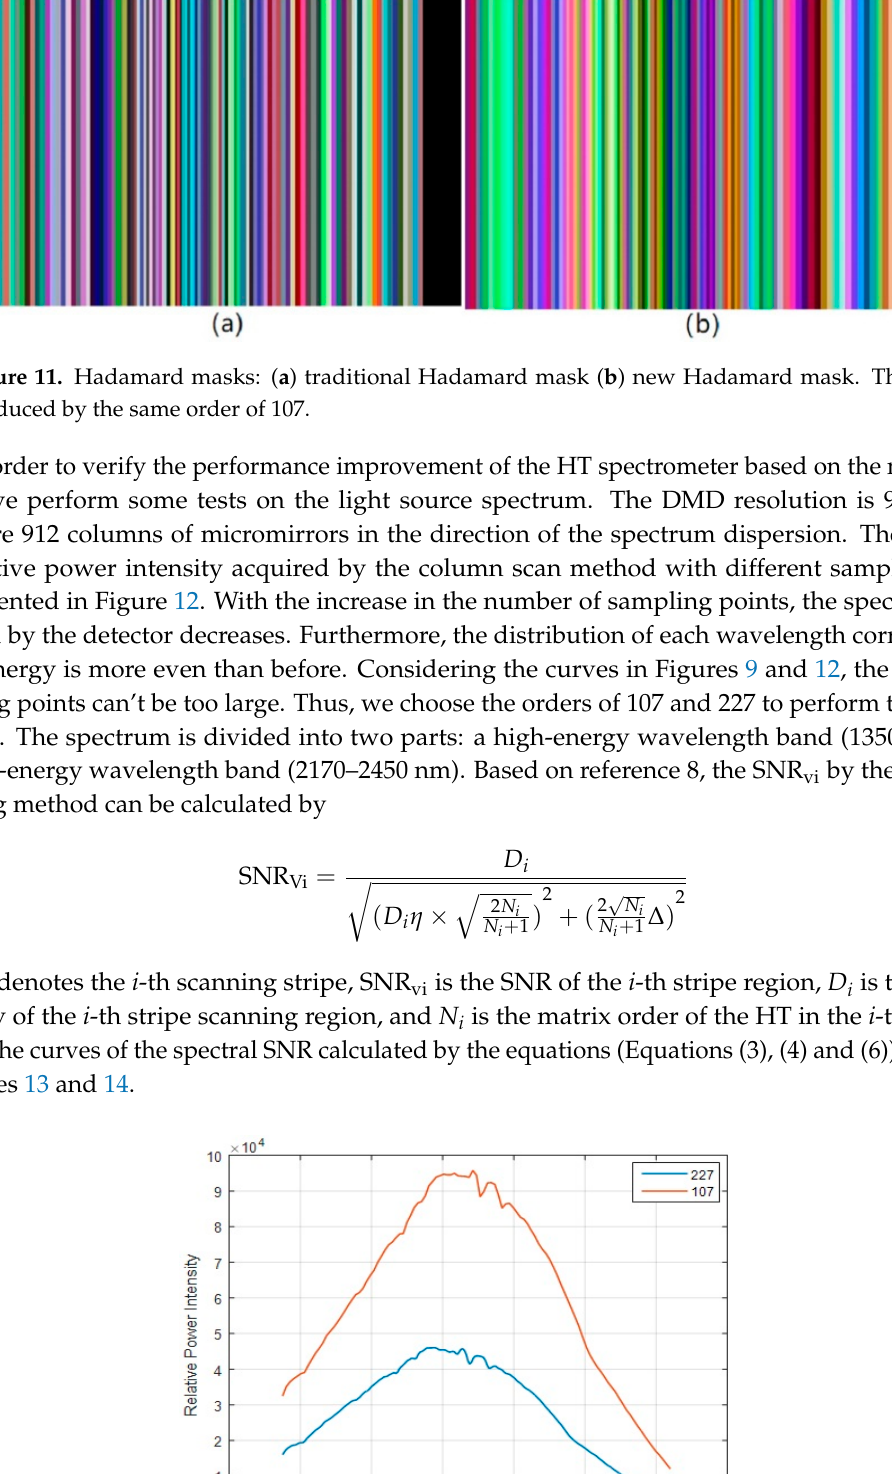
Figure 10. Flowchart of mask optimization.